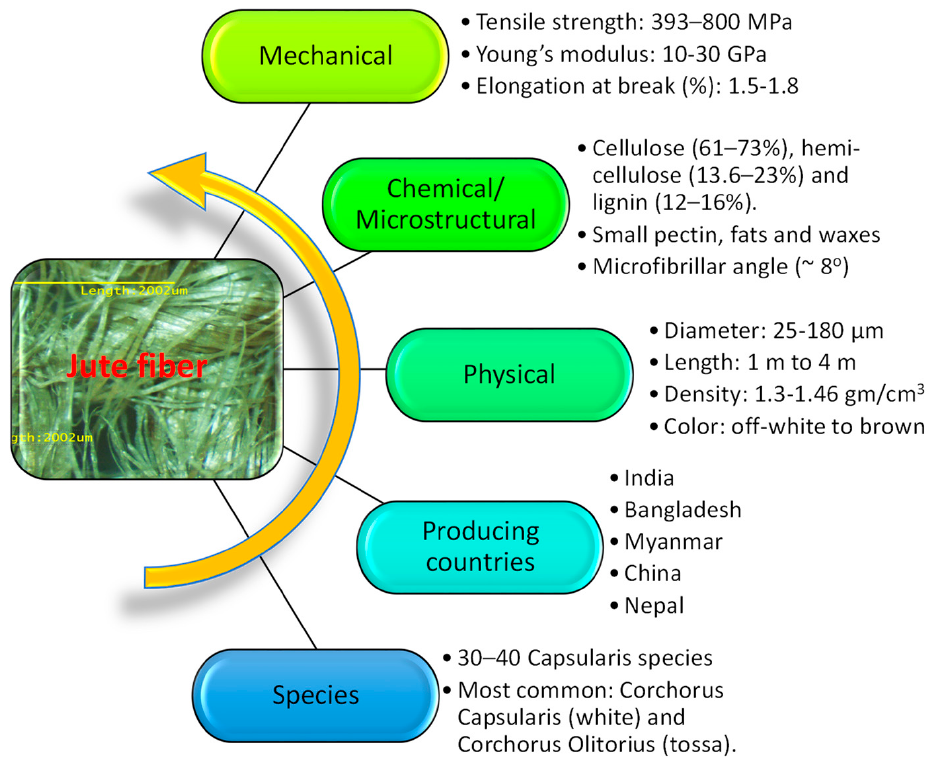
Figure 2. Facts and figures about jute. (Information taken from [6–9]).